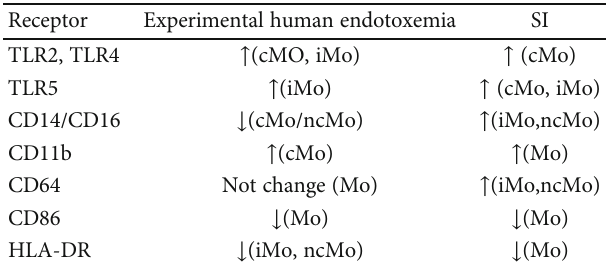
Table 1: Change of the receptor expression on monocytes during EE and SI.